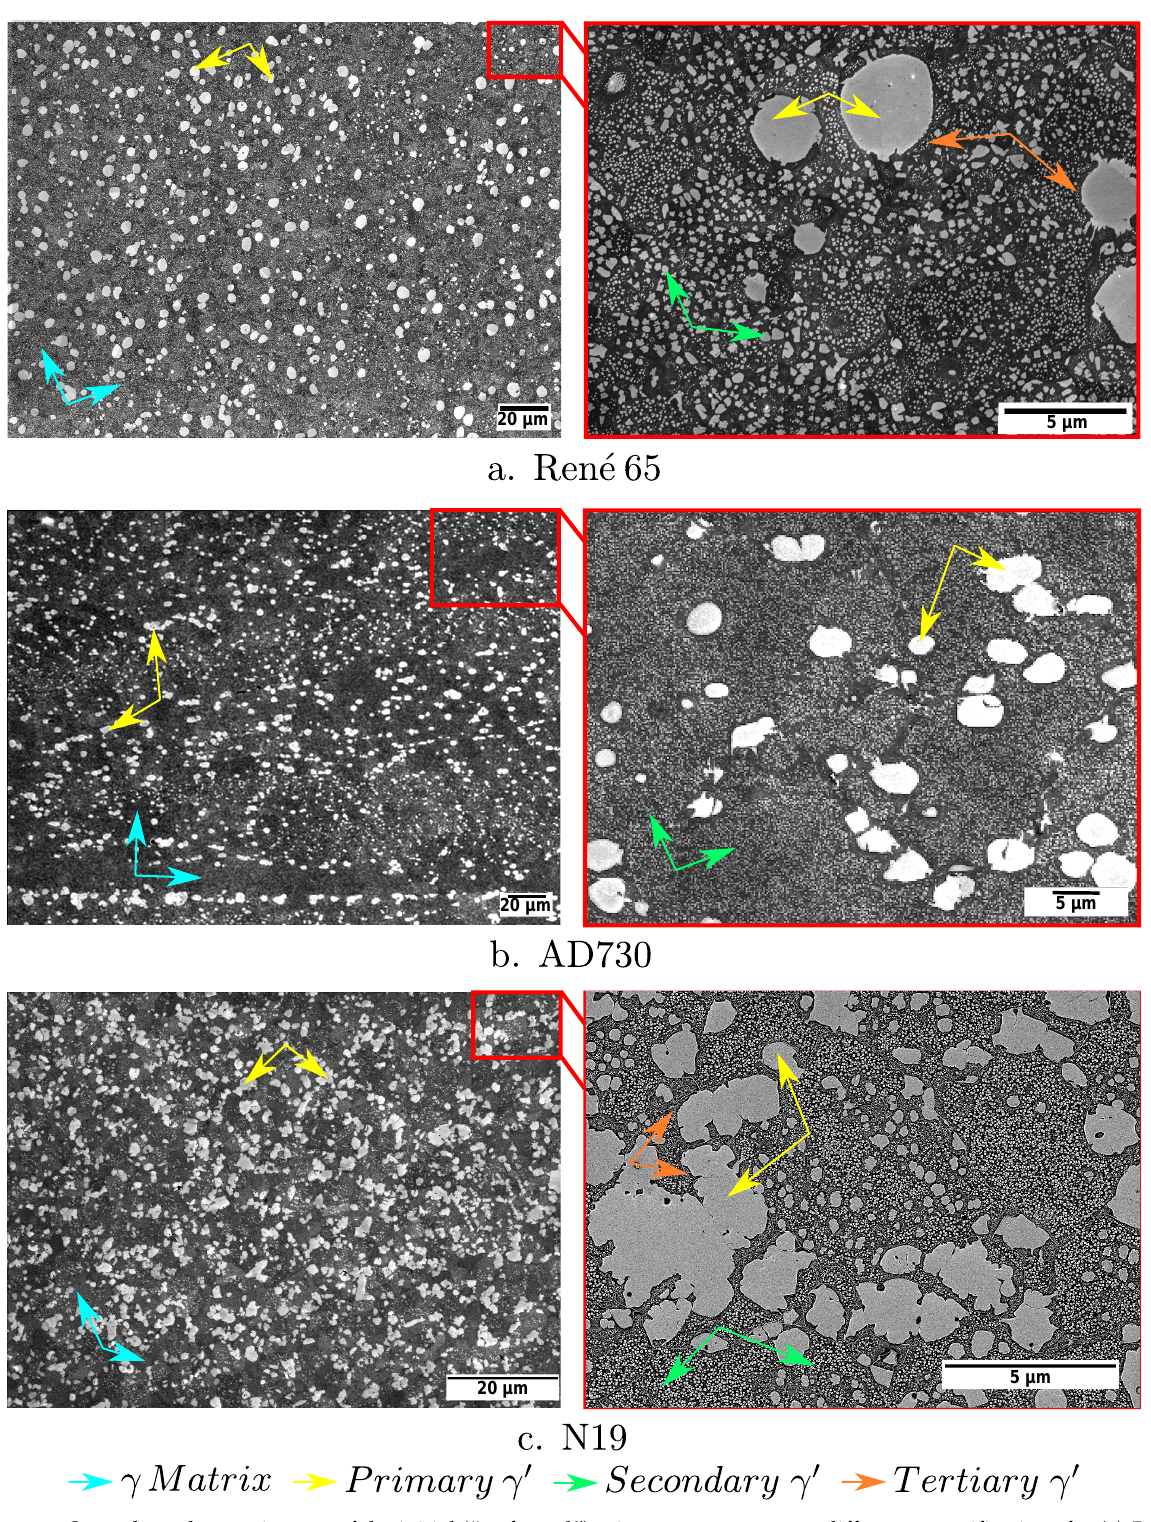
Figure 1. Secondary electron images of the initial (“as-forged”) microstructures at two different magnifications for ( a ) René 65; ( b ) AD 730 and ( c ) N 19